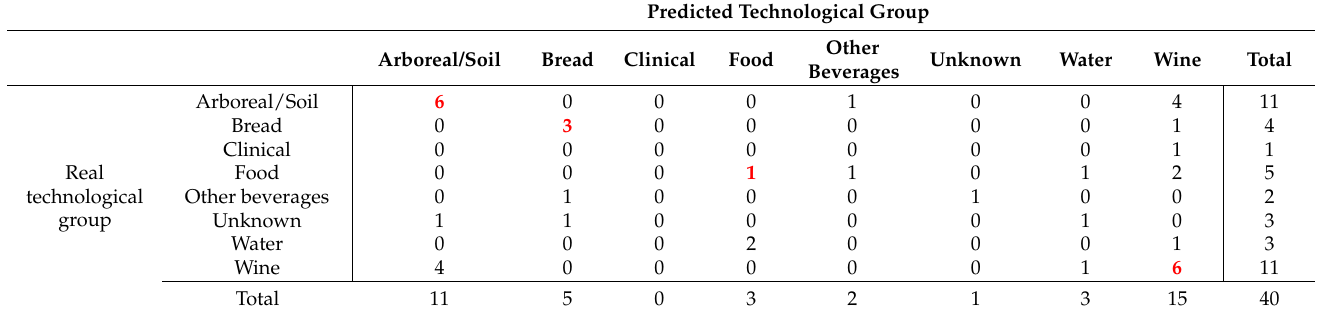
Table 2. Confusion matrix indicating the technological group of 40 T. delbrueckii strains versus the technological group predicted using neural networks (AUC = 0.718). Correct predictions are highlighted in